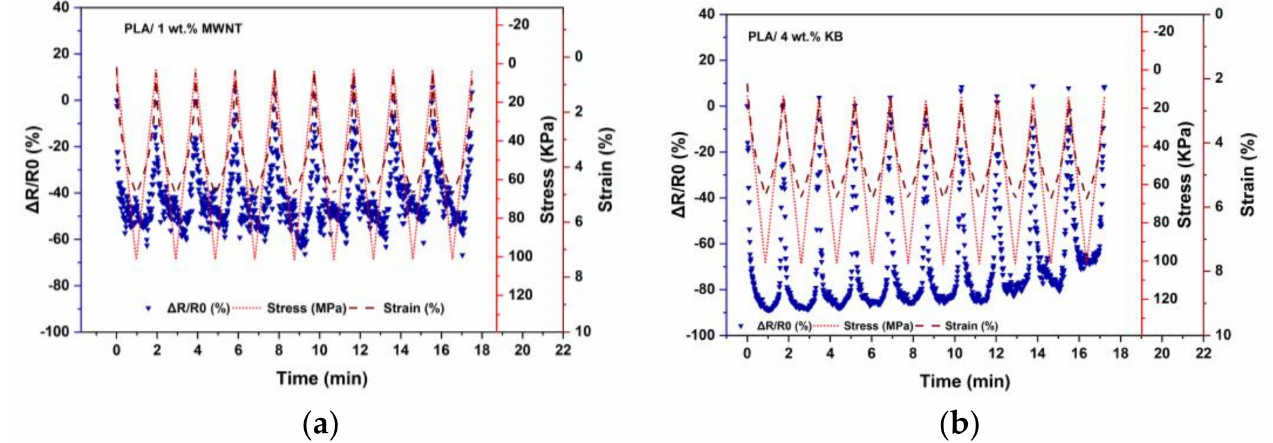
Figure 7. Comparison of 3D-printed nanocomposites piezoresistive responses in high force rate of 18 N/min ( a ) PLA/1 wt.% MWNT ( b ) PLA/4 wt.%